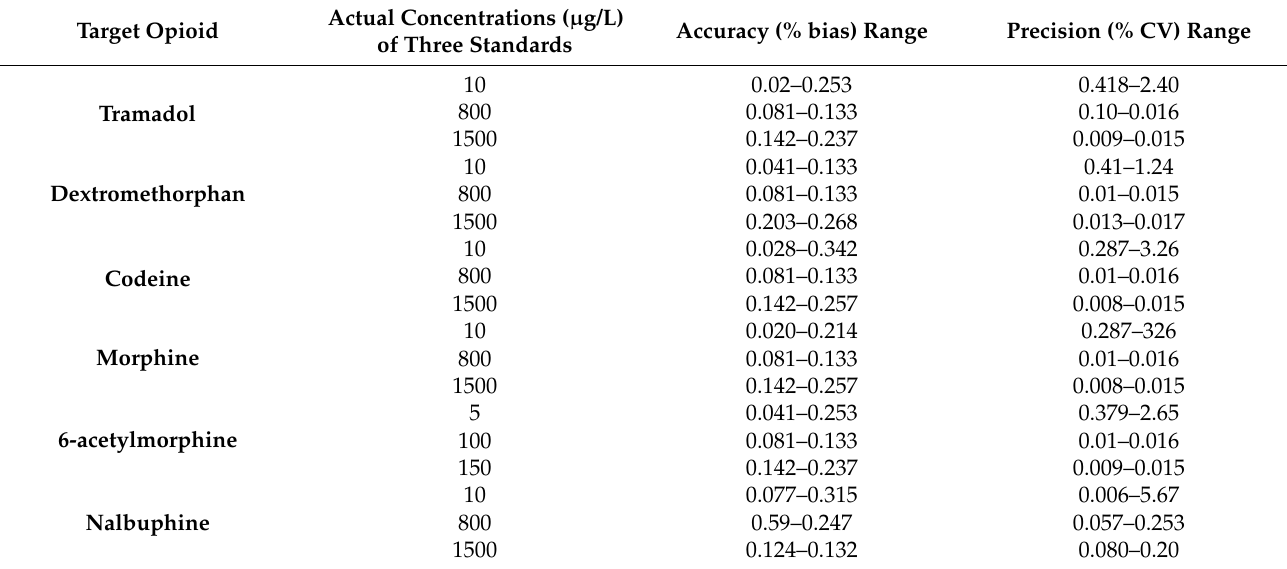
Table 4. Three concentrations (lower, middle and high) were selected, and the triplicate of each concentration was run over five days in different batches. Table 4. Accuracy (% bias) and precision (% CV) of all target opioids.